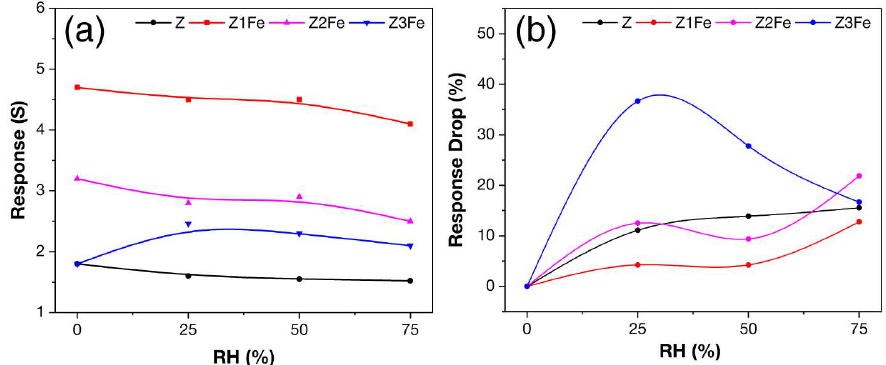
Figure 12. Dependence of response value on humidity ( a ) and response drop (RD) in a humid environment ( b ) when detecting 500 ppb NO 2 at 175 ◦ C with ZnO/Fe 2 O 3 thin